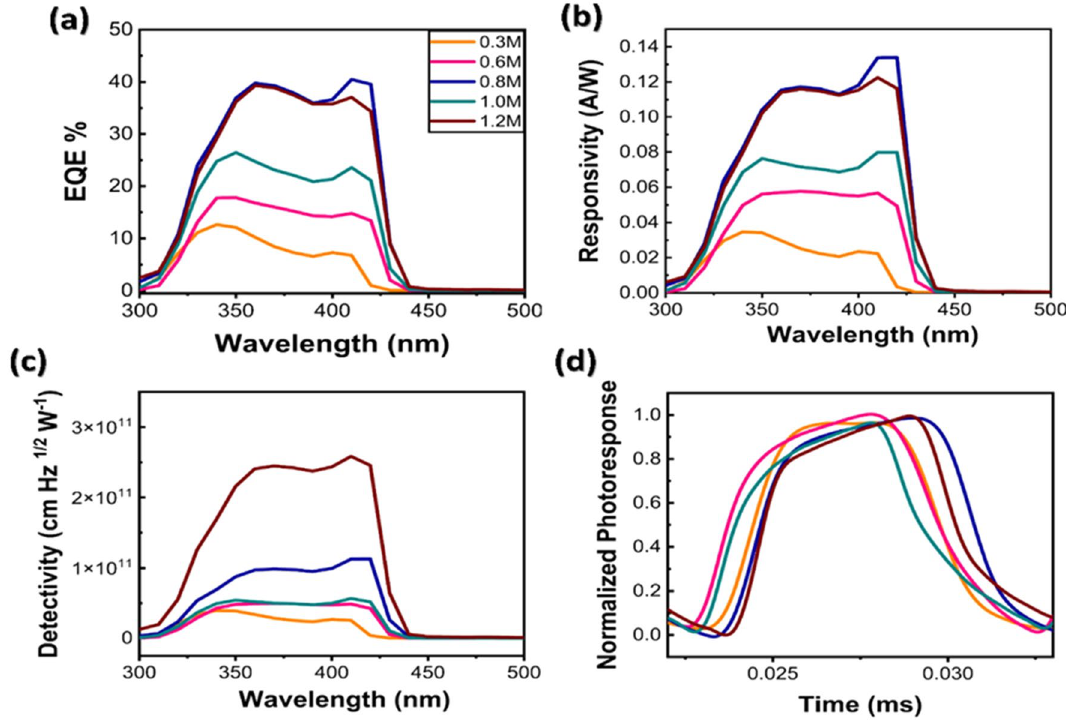
Figure 8. ( a ) EQE, ( b ) Responsivity, ( c ) Detectivity spectra, and ( d ) Normalized photo-responses of 1.5% Cs under 100 Hz optical